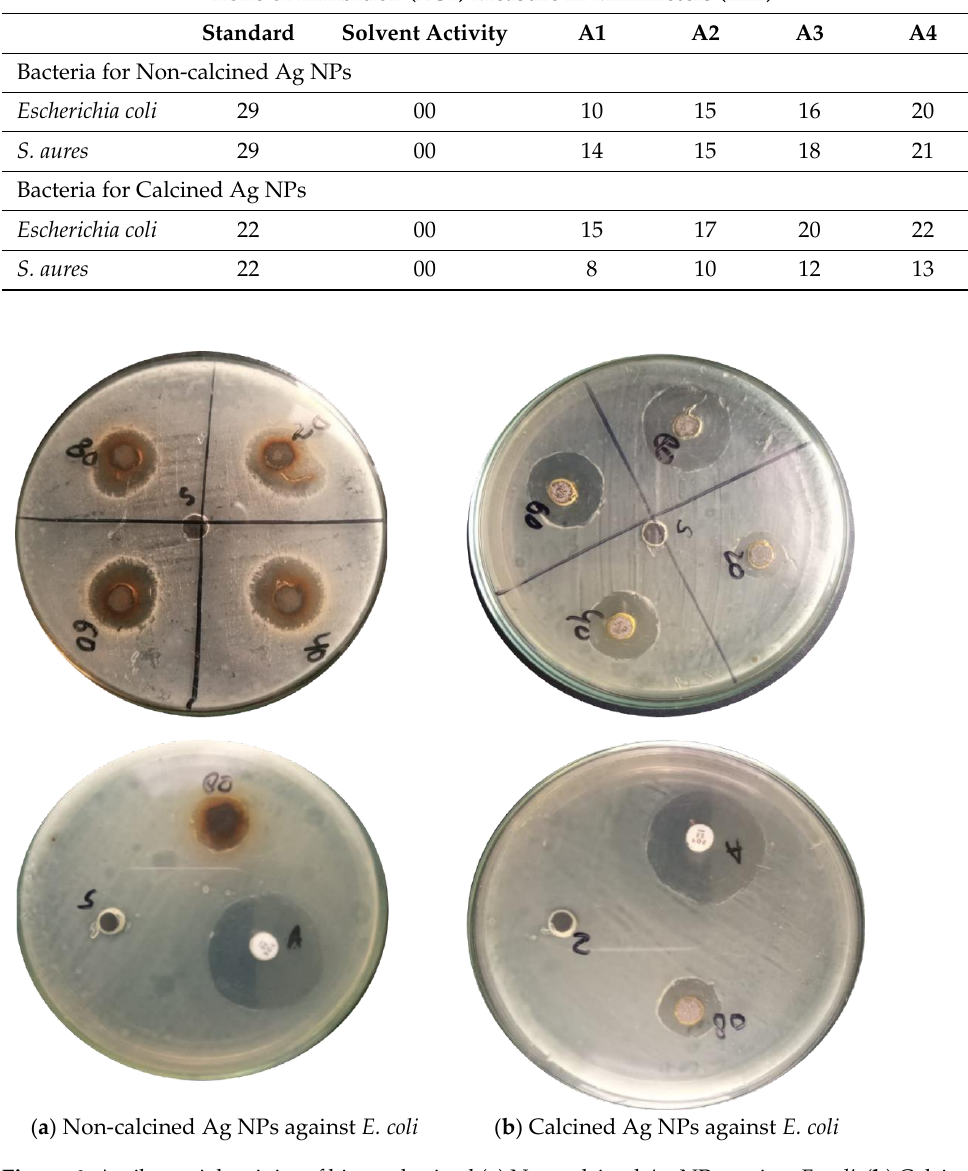
Figure 6. Antibacterial activity of biosynthesized ( a ) Non-calcined Ag NPs against E. coli , ( b ) Calcined Ag NPs against E. coli